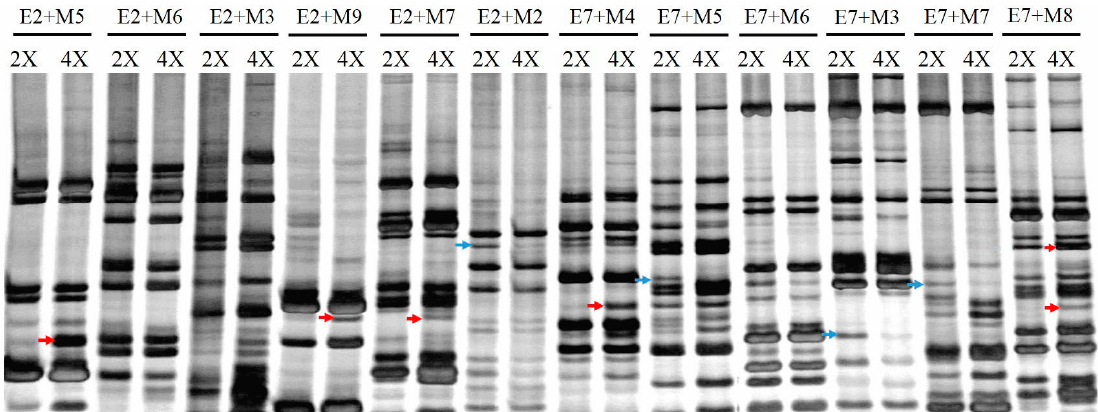
Figure 3. Typical cDNA-AFLP profiles of the diploid and the tetraploid. Upper panel represents primer combinations. 2X indicates diploid, and 4X indicates tetraploid plants. “ → ” to red arrows represent up-regulated genes and blue arrows represent down-regulated genes in tetraploid plants. Bands detected range from 100 to 500 bp. Table 2. Level of cytosine methylation in the autopolyploid.